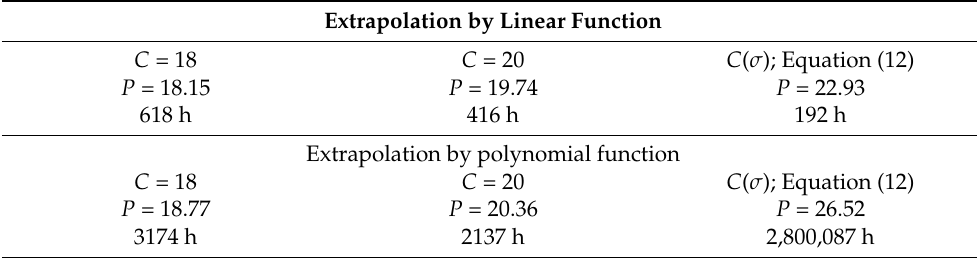
Table 3. Estimated time to rupture at 80 MPa and 873 K for different assumptions of LMP model. Extrapolation by Linear